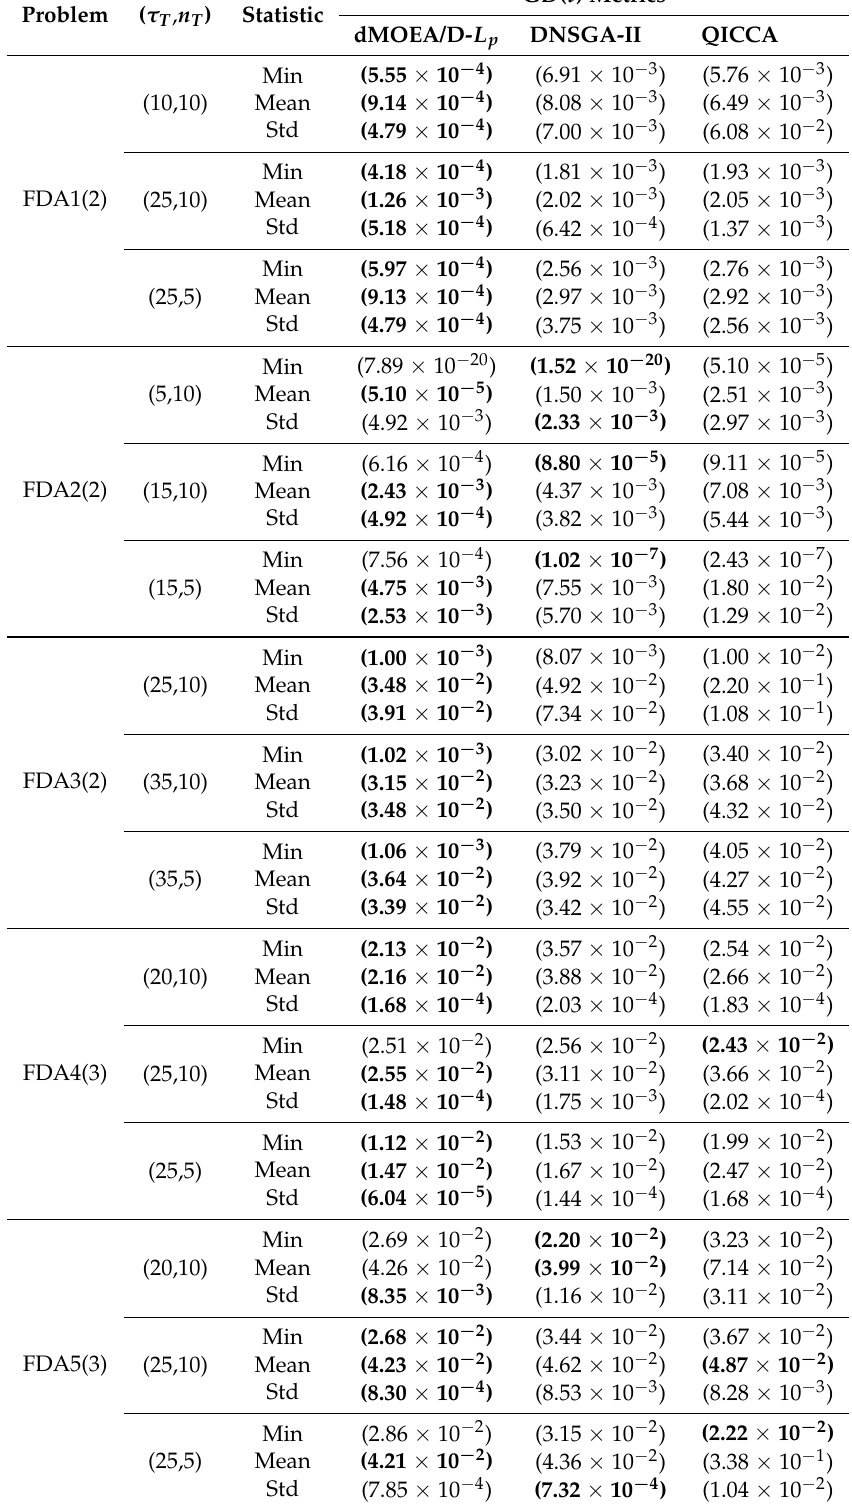
Table 7. The best, mean, and standard deviation of GD( t ) metric values obtained by dMOEA/D- L p and the other two compared algorithms on test problems based on 30 independent runs. The best performance of each metric value is marked in